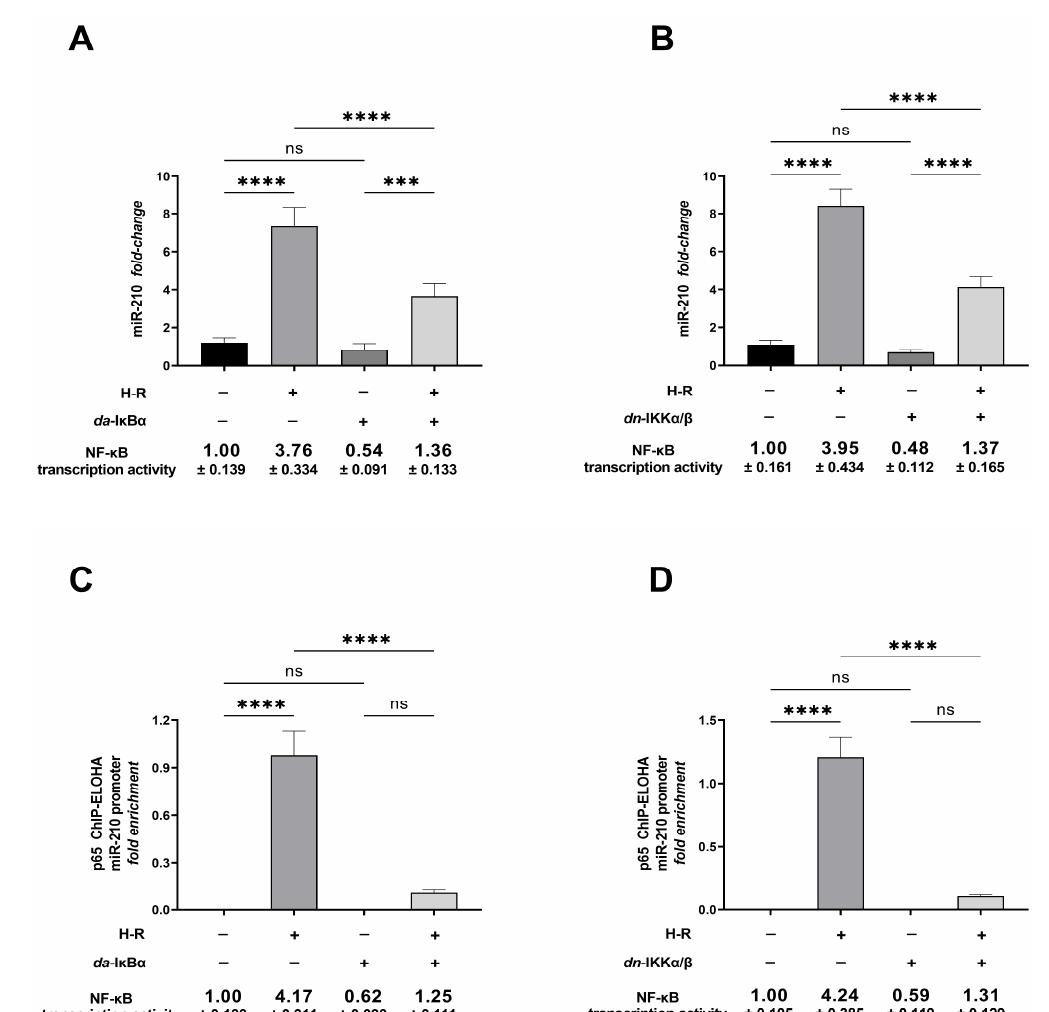
Figure 2. The activation and recruitment of NF- κ B to the miR-210 proximal promoter is in- dispensable for the hypoxia–reoxygenation (H-R)-induced miR-210 expression. ( A , B ) Enzyme- coupled miR-210 hybridization immunoassay determining miR-210 levels in H-R challenge-subjected cells ectopically expressing either the da -I κ B α ( A ) or dn -IKK α / β ( B ) mutants to inhibit NF- κ B activation. ( C , D ) Tandem ChIP-ELOHA analysis showing the relative enrichment of p65 NF- κ B at the κ B response element in the miR-210 proximal promoter in response to H-R challenge-subjected cells ectopically expressing either the da -I κ B α ( C ) or dn -IKK α / β ( D ) mutants to inhibit NF- κ B ac- tivation. Data from miR-210 hybridization immunoassay are expressed as mean fold change ± S.D. from three technical replicates for each of the four biological replicates belonging to each experi- mental group ( n = 4). The ectopic expression of the HA-tagged da -I κ B α and HA-tagged dn -IKK α / β mutants was validated using ELISA immunoassay performed against the HA tag (Supplementary Figure S3A–D). NF- κ B transcriptional activity (( A – D ), bottom panel) was determined in the native lysates to corroborate and validate the translative effects of the ectopic expression of the da -I κ B α and dn -IKK α / β mutants. Data from the ChIP-ELOHA analysis are expressed as fold enrichment by first correcting the p65 NF- κ B-associated miR-210 promoter fragment ELOHA absorbance values to the respective inputs, followed by normalization to fold change values. Data from the ChIP-ELOHA analysis are depicted as mean fold enrichment ± S.D. from three technical replicates for each of the four biological replicates belonging to each experimental group ( n = 4). *** p ≤ 0.001; **** p ≤ 0.0001; ns: not significant ( p > 0.05) S.D.: standard